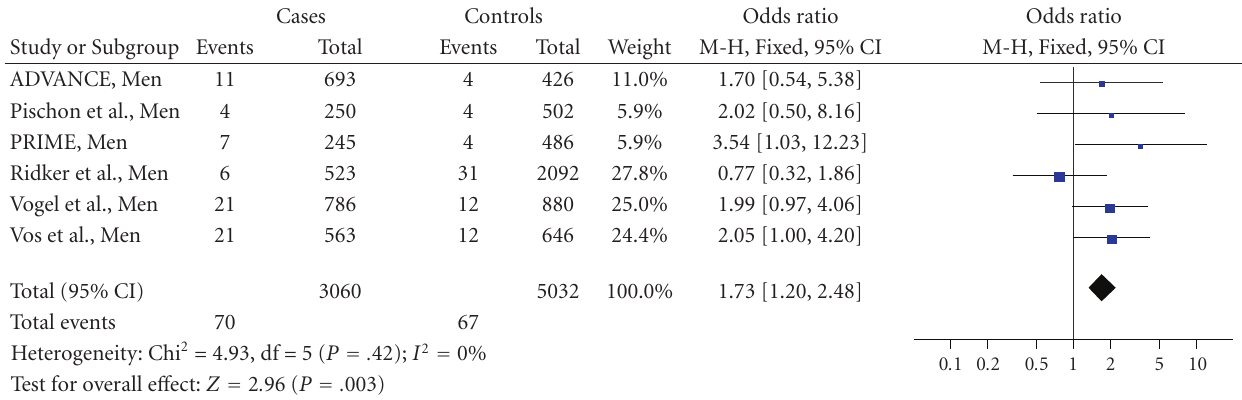
(c) Meta-analysis of CHD risk for the PPARG Pro12Ala polymorphism under the recessive model in men.